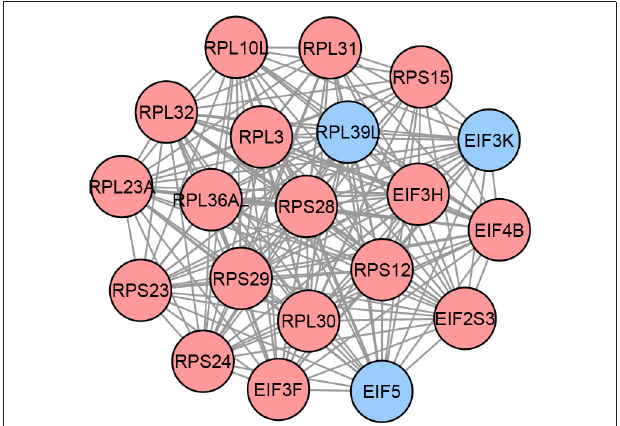
FIGURE 4 | Proposed network-based signature for LGG, containing a total of 20 genes organized in a clique. Each node in this graph represents a gene, while each edge describes the interaction between a gene pair. The interactions are retrieved from the STRING database. The colors of the nodes represent the effect sizes obtained from the meta-analysis step described in Figure 1A : red represents genes with a positive effect size while blue represents genes with a negative effect size.